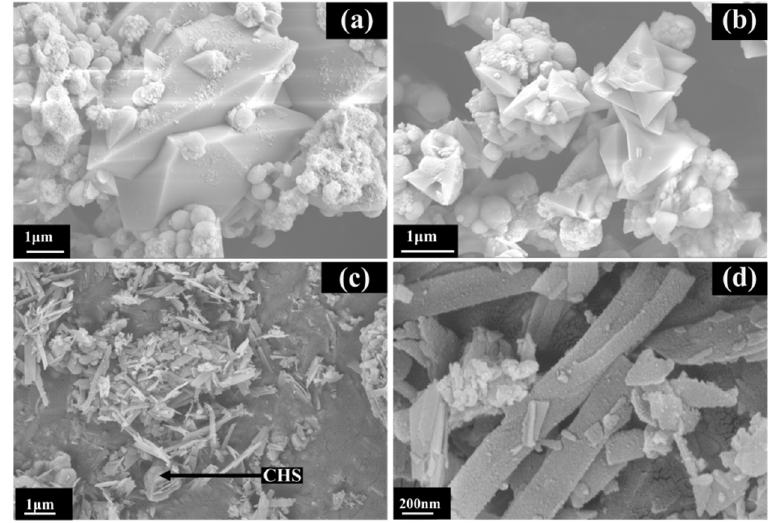
Figure 6. SEM images examining the effect of reaction time on the morphology of the product for ( a ) and ( b ) To-13, ( c ) To-14, ( d ) To-15.